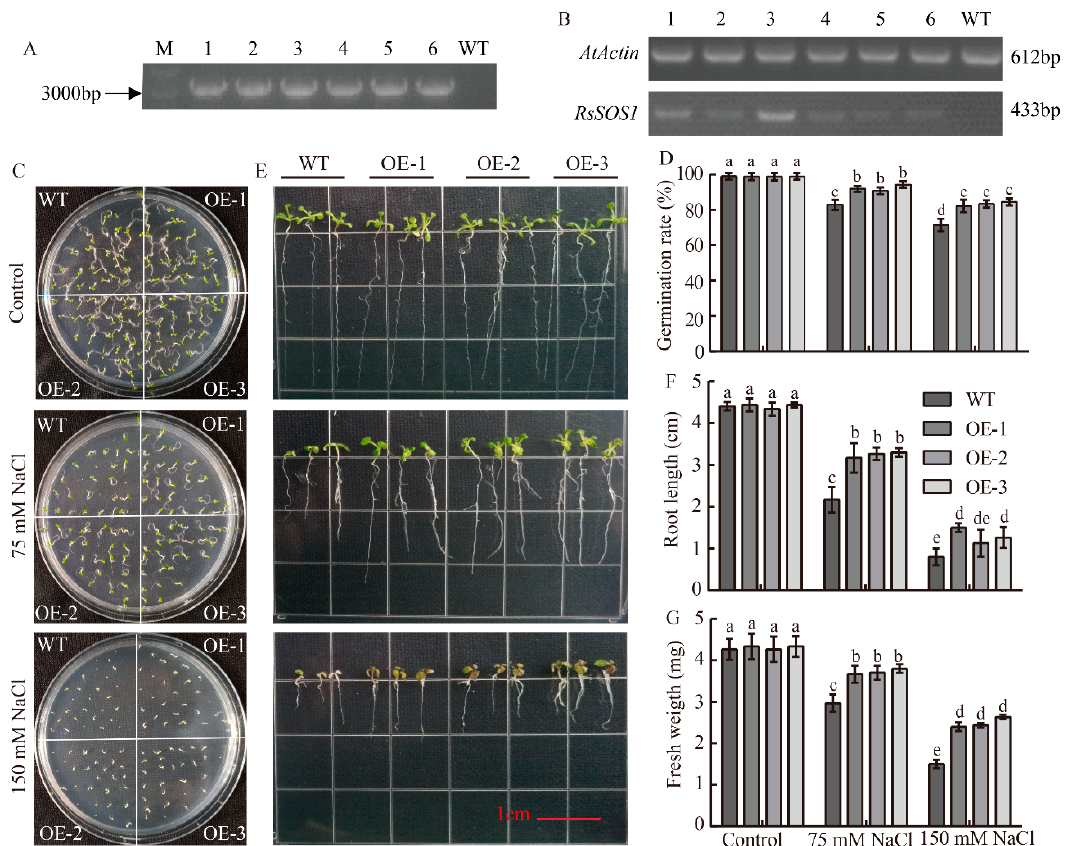
Figure 5. Overexpression of RsSOS1 in Arabidopsis. ( A , B ): PCR identification and RT-PCR validation of RsSOS1 transgenic Arabidopsis, respectively; ( C ) The germination of OE- RsSOS1 transgenic Arabidopsis under salt stress; ( D ) Statistics of germination rate of OE- RsSOS1 plant under salt stress; ( E ) Phenotype of OE- RsSOS1 under NaCl stress; ( F , G ) Statistics of root length and fresh weight. M, DL 5000 Marker. WT, wild type Arabidopsis . 1–6, six transgenic Arabidopsis lines. Error bars indicate SD, letters represent significant differences at p < 0.05 level based on Duncan’s test.